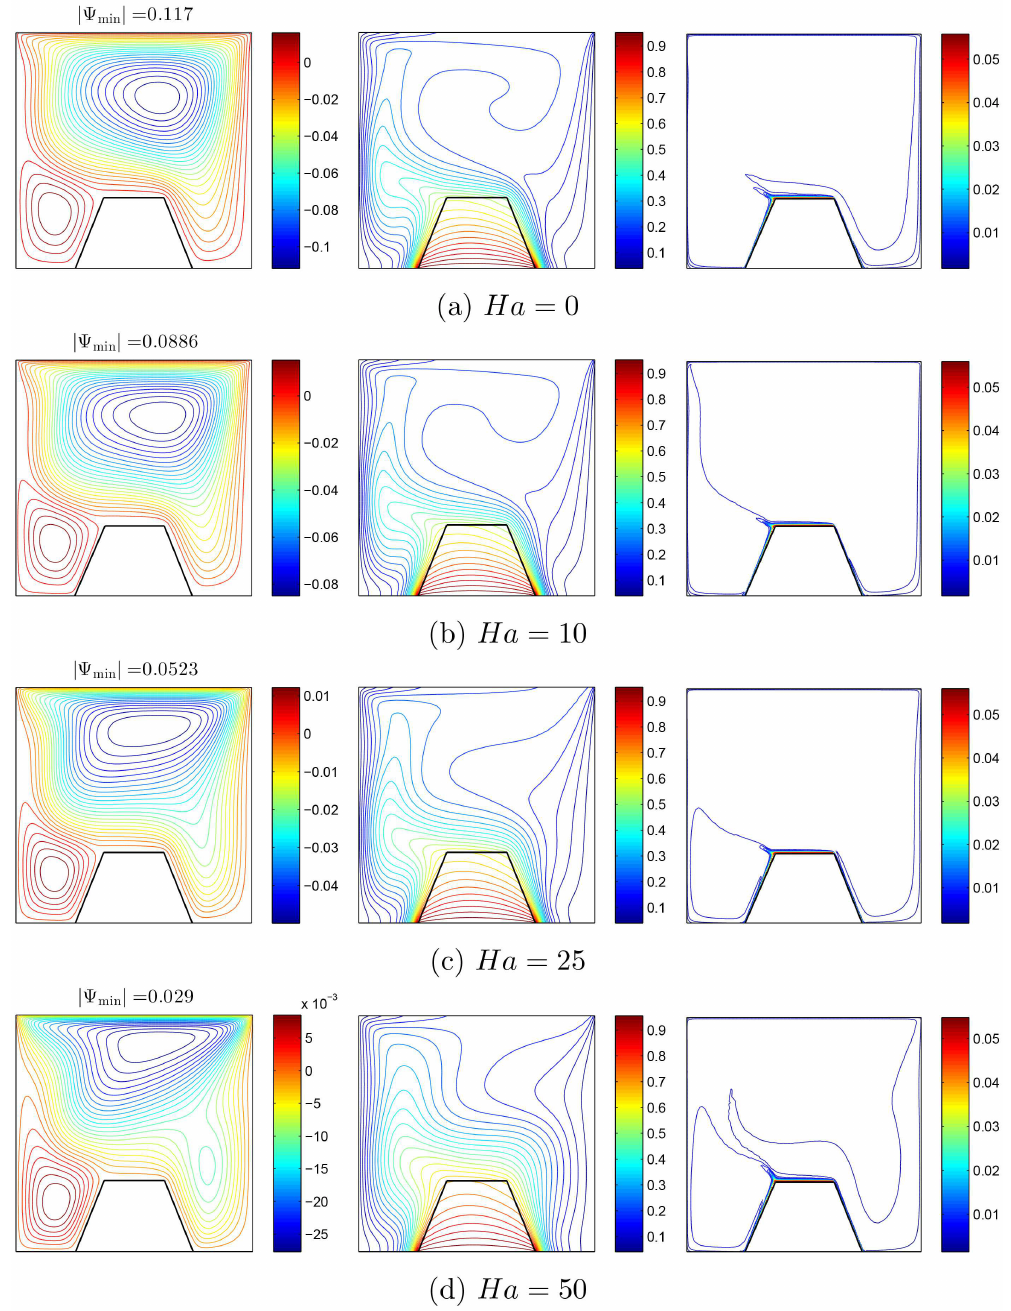
Figure 7. Effects of the Hartmann number ( Ha ) on the streamlines (left), isotherms (middle), and nanoparticle distribution (right) for Ri = 10, φ = 0.02, and D = 0.3. The impacts of the solid volume fraction ( φ ) on the streamlines, isotherms, and nanoparticle distribution are described in Figure 8 for Ri = 10, Ha = 15 and D = 0.3. The flow circulation shows less enhancement as the solid volume fraction increases; however, the strength of the flow circulation increases, which is clearly related to the nanoparticle Brownian diffusion. The isotherm lines show more deterioration and more lines move to the left wall, which is evidence of the temperature gradient increment. The temperature gradient leads to an increment in the thermophoresis; the nanoparticles show high distribution next to the right cold wall. The Brownian movements increase with such a loading of nanoparticles; nanoparticle migration mostly occurs close to the trapezoidal solid